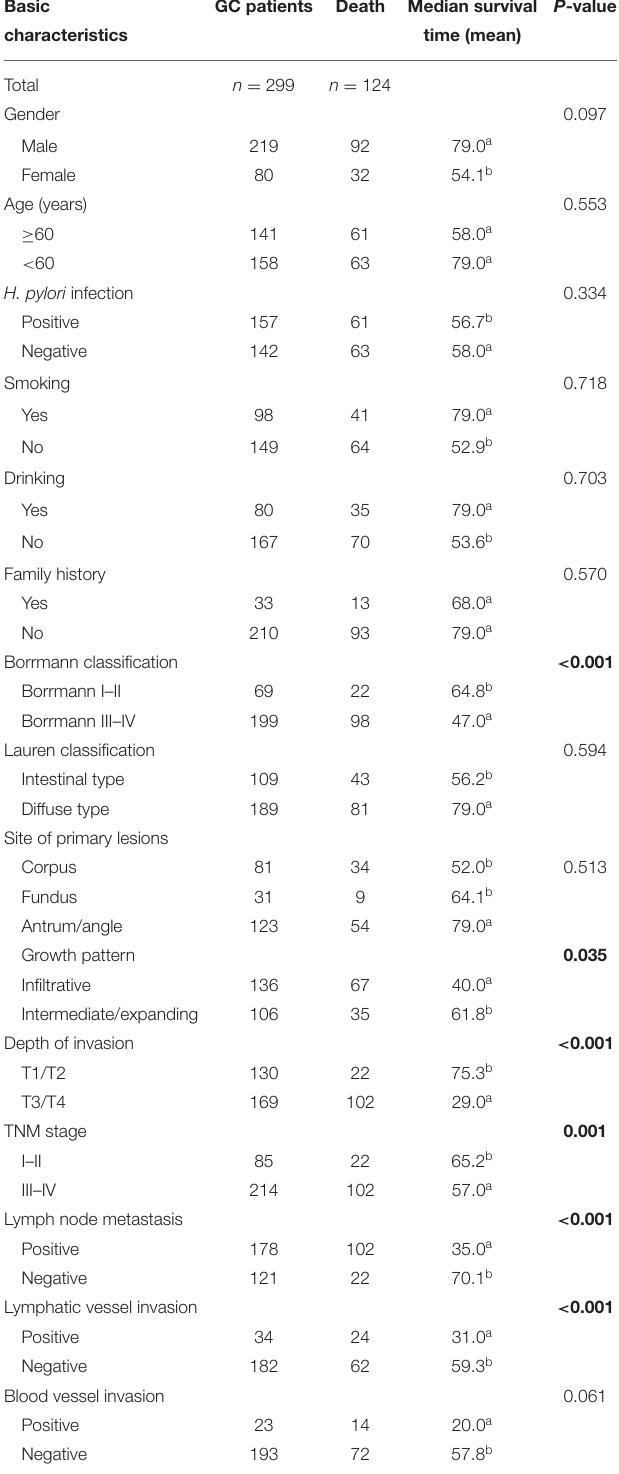
TABLE 5 | The correlation between basic characteristics and gastric cancer (GC) prognosis.